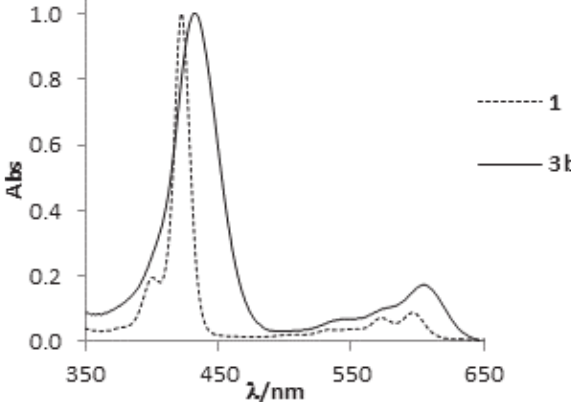
Figure 3 - Normalized UV–Vis spectra of compounds 1 and 3b in DMSO.